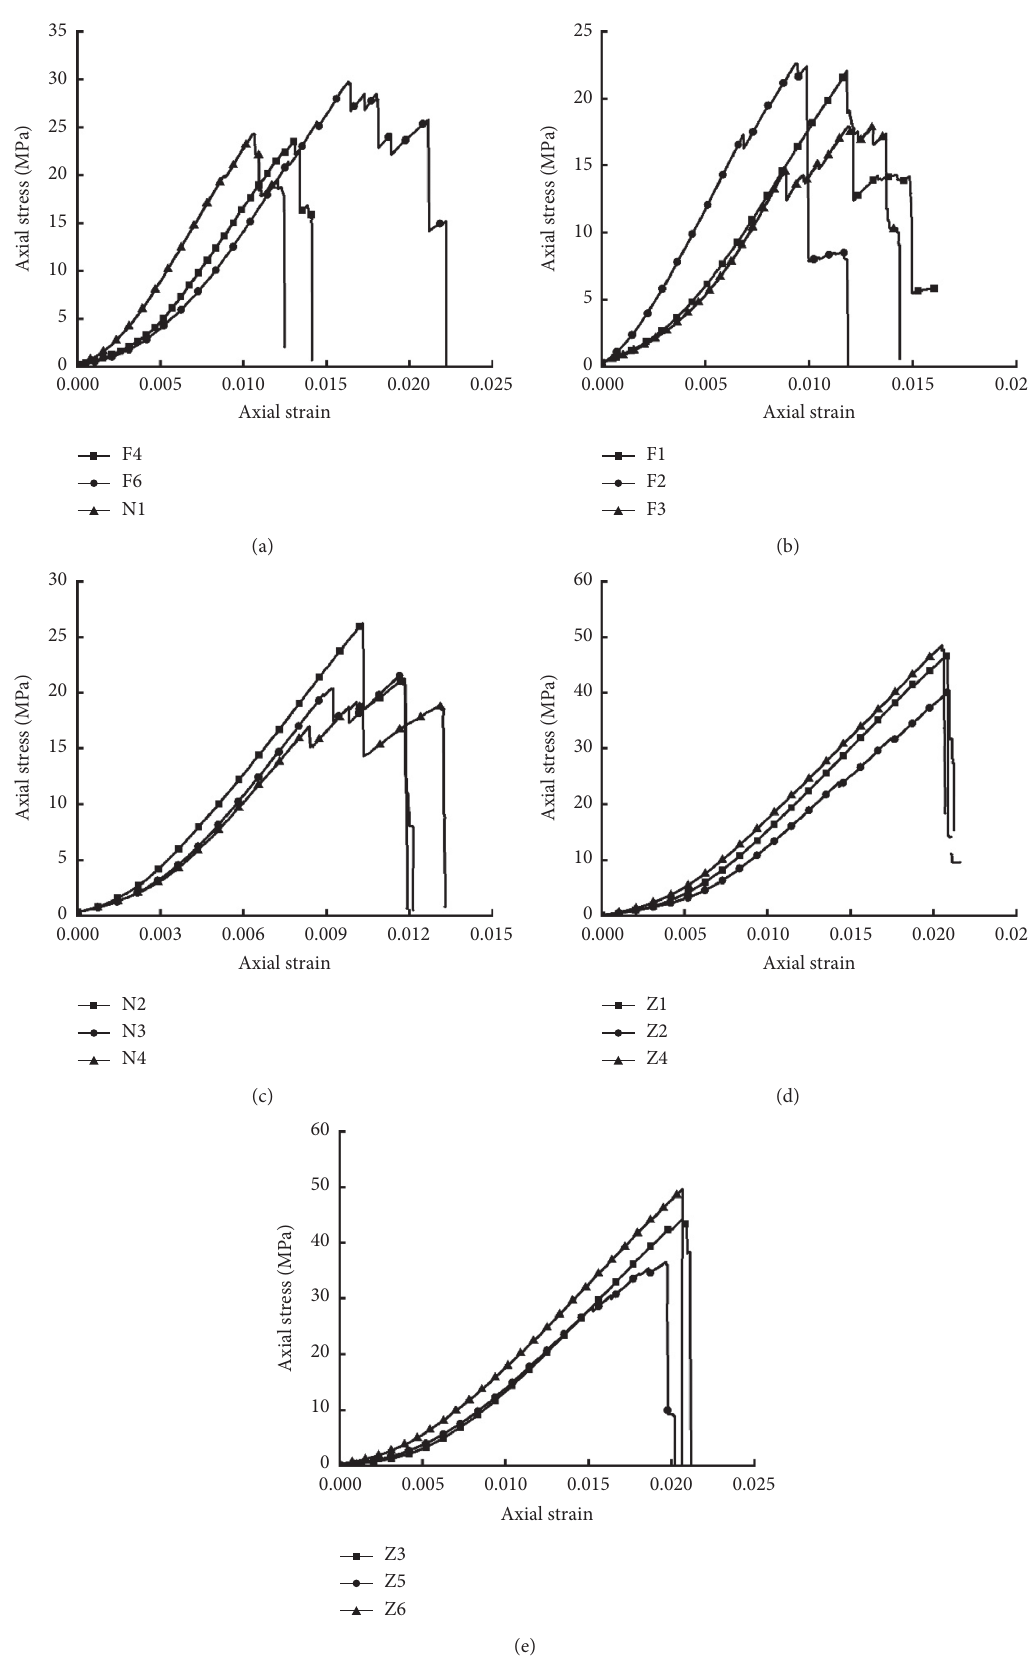
Figure 4: Stress-strain curve: static compression